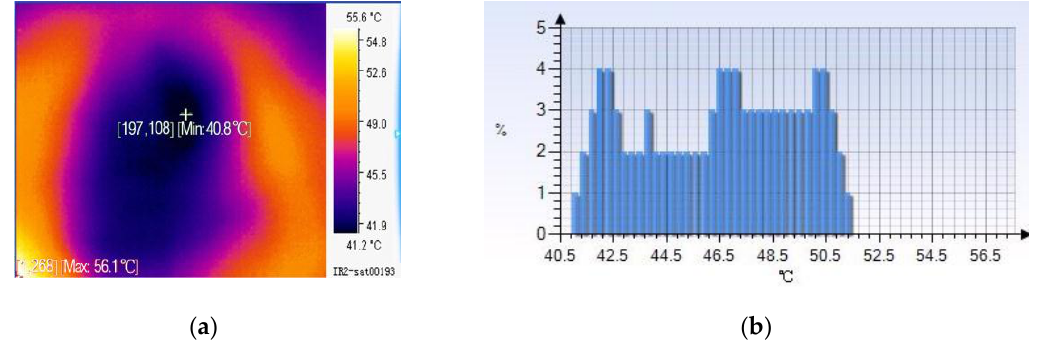
Figure 7. Infrared imaging and temperature distribution before irrigation at 10:36 a.m., ( a ) Infrared imaging; ( b ) Temperature distribution diagram.